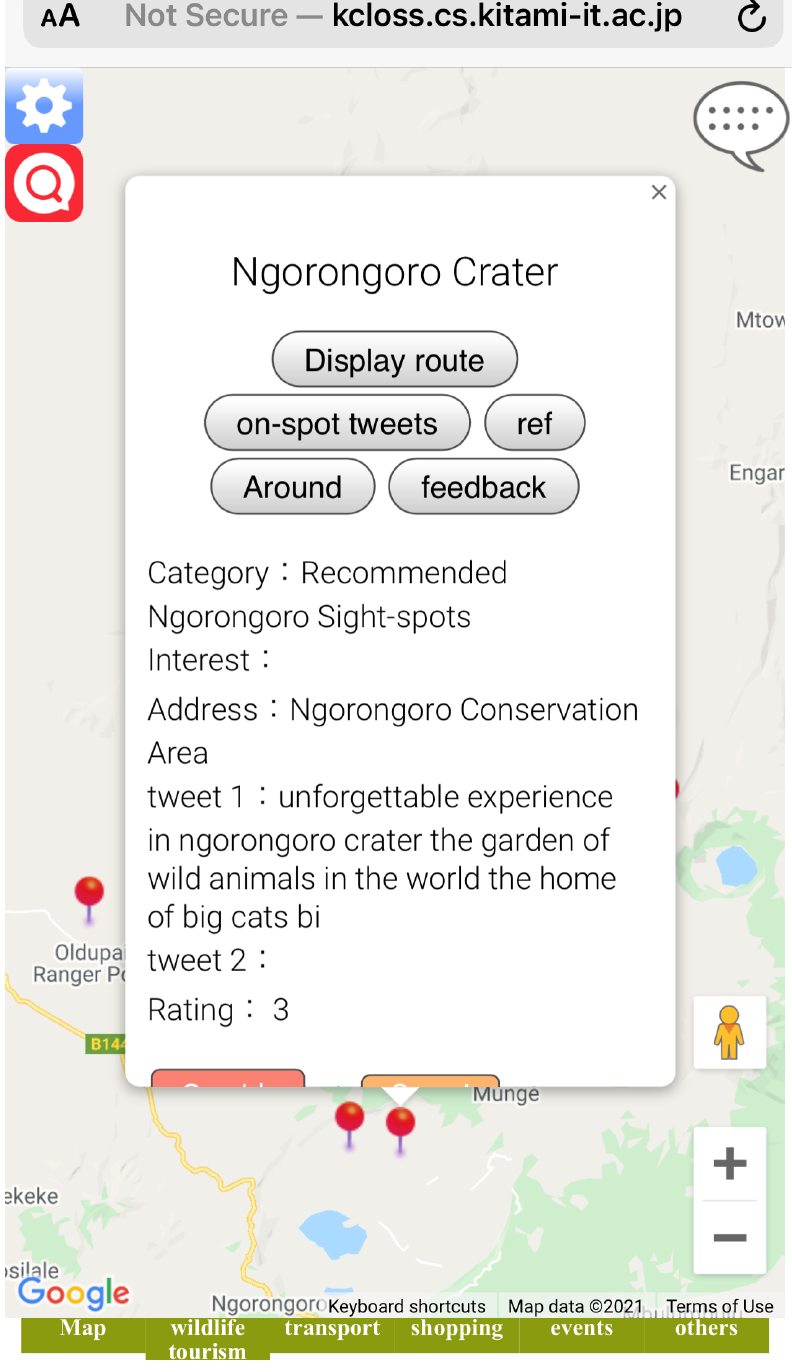
Figure 13. Rating information on sightspot